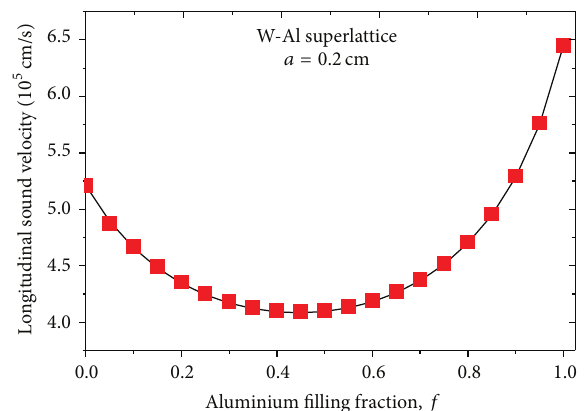
Figure 6: Effective sound velocity for longitudinal vibrational modes propagating along the growth direction of a W-Al superlat- tice. Here, solid line was obtained by using formula (33) and squares were obtained by using formula